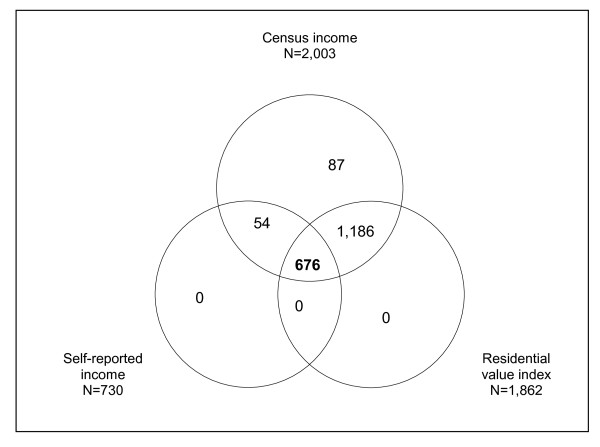
Venn diagram depicting the availability of the three indicators of material circumstances among study subjects (N = 2,003).